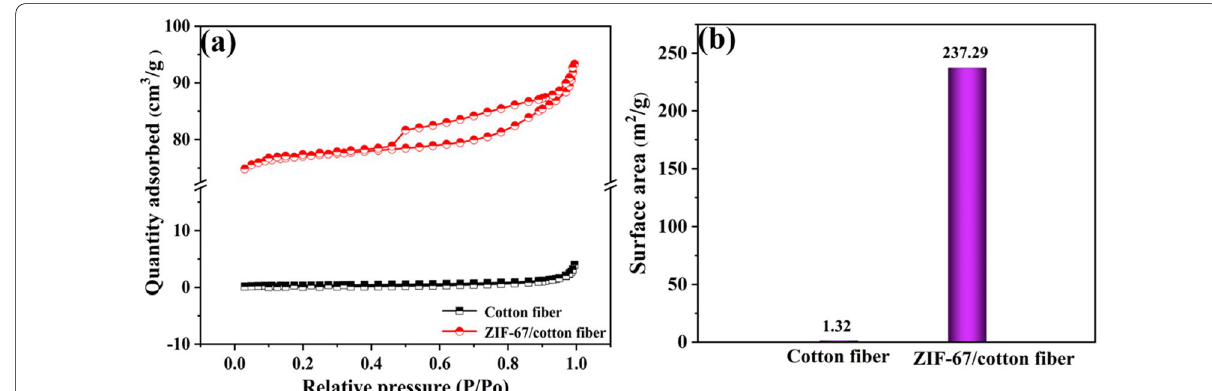
Fig. 4 Nitrogen adsorption–desorption of the pristine cotton fibers and ZIF-67/cotton fibers, respectively ( a ), BET surface areas of the pristine cotton fibers and ZIF-67/cotton fibers ( b